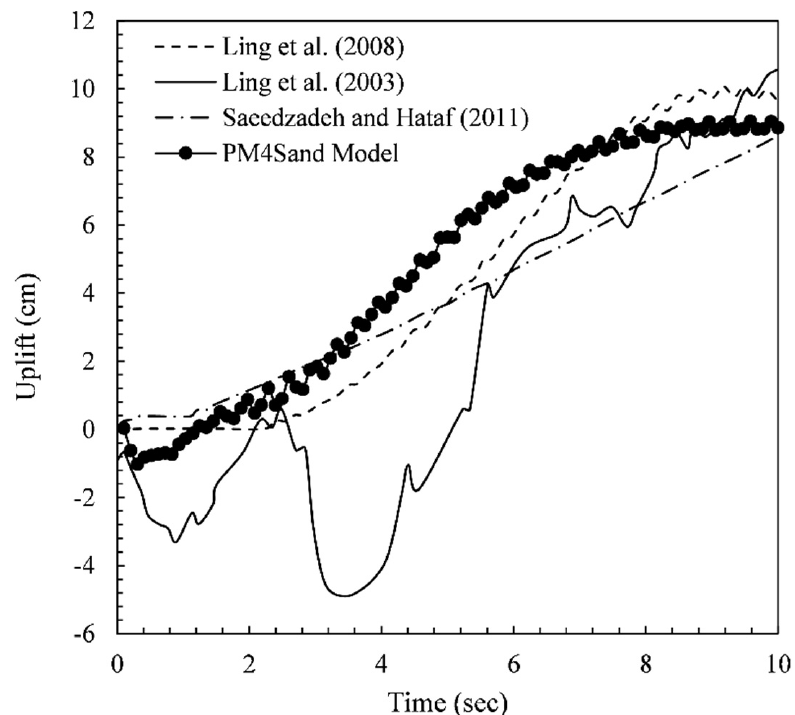
Figure 3. Comparison of the pipe upheaval buckling obtained from the current study and past studies under dynamic loading.